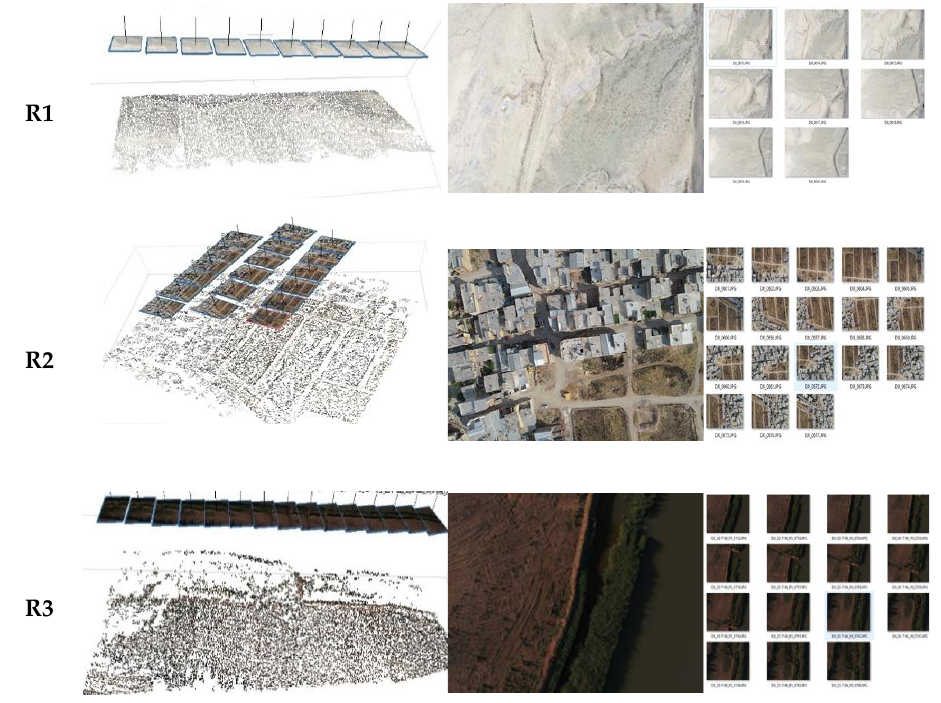
Figure 5. The employed real datasets with their images and different camera networks. They feature high-resolution images, variable image overlap, and texture-less surfaces. Table 2. Specifications of the real image datasets.